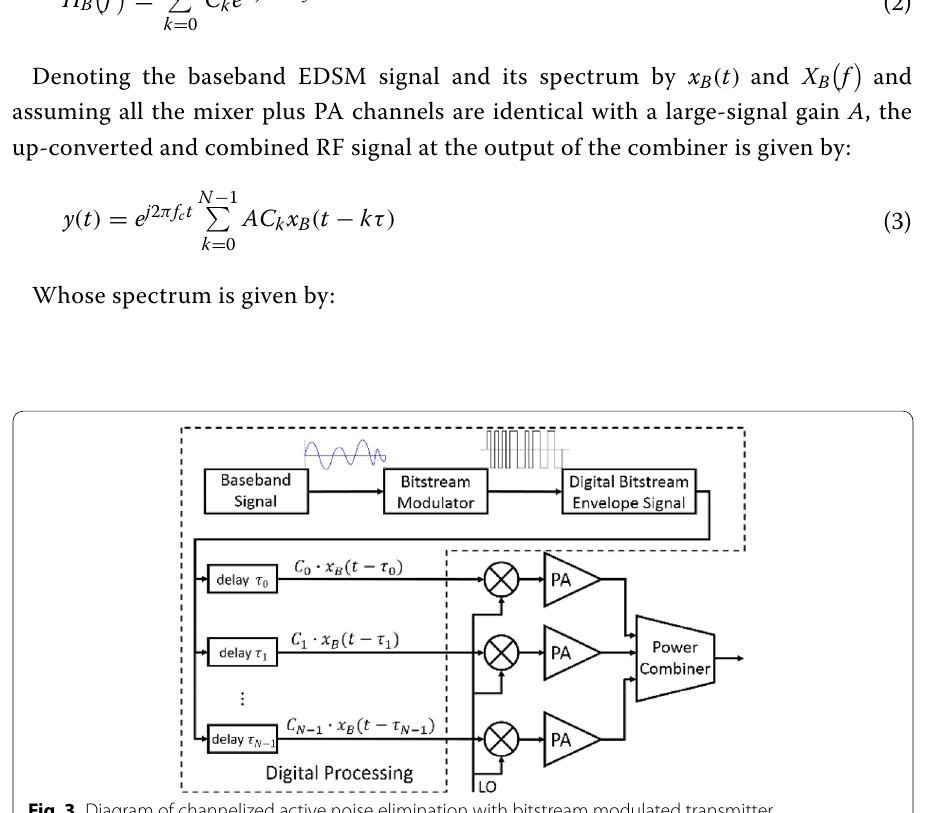
Fig. 3 Diagram of channelized active noise elimination with bitstream modulated